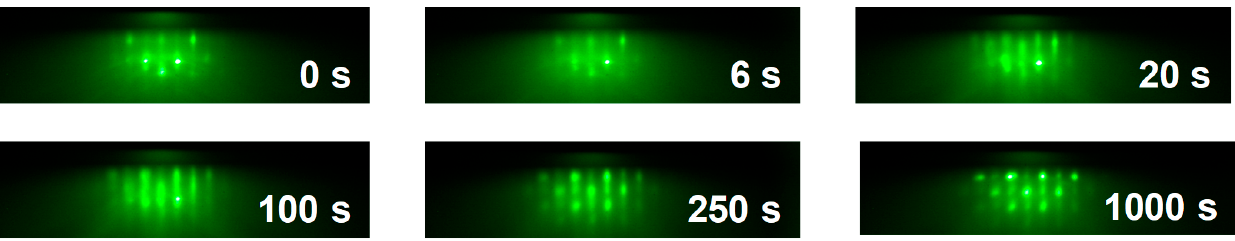
Figure 1. Representative RHEED patterns along [100] azimuth observed during the growth of (100) BST-0.5 thin film on single crystal (100) STO as a function of time, and therefore, increasing film thickness. Note, very little streaking in (100) STO substrate prior to deposition (t = 0 s) is indicative of a diffracting surface with long terraces.